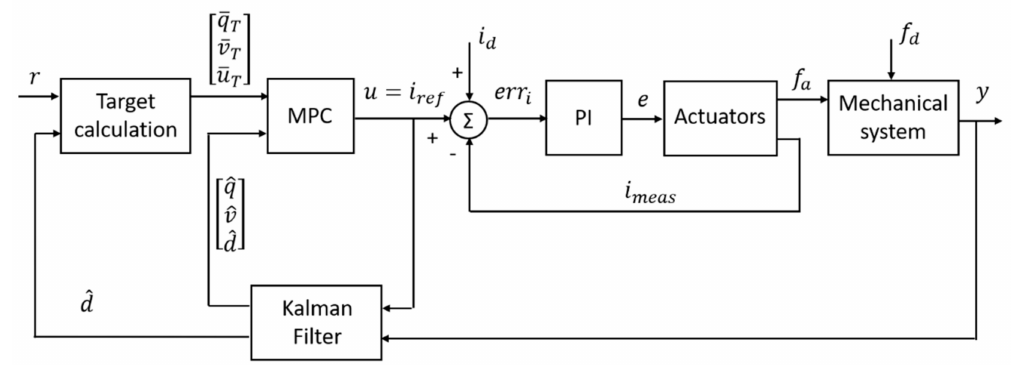
Figure 2. Control system